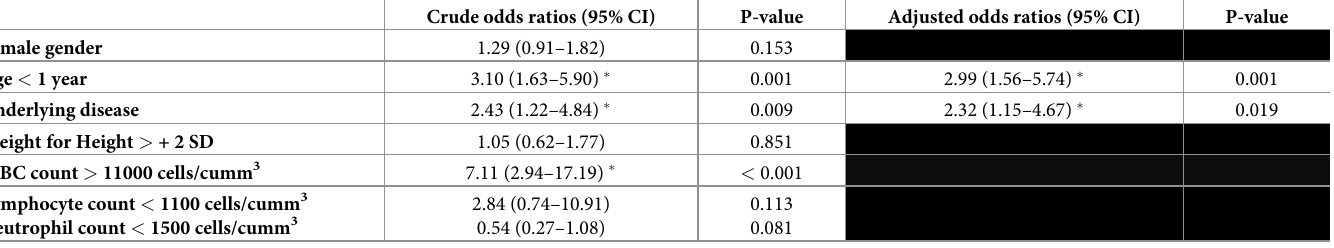
ORs and adjusted ORs for the children with pneumonia were summarized in Table 5. Table 5. Associating factors in children with